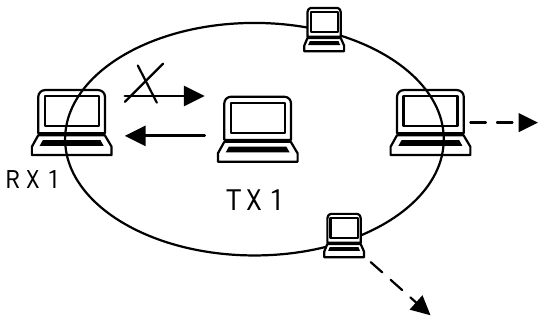
Figure 9. Asynchronous